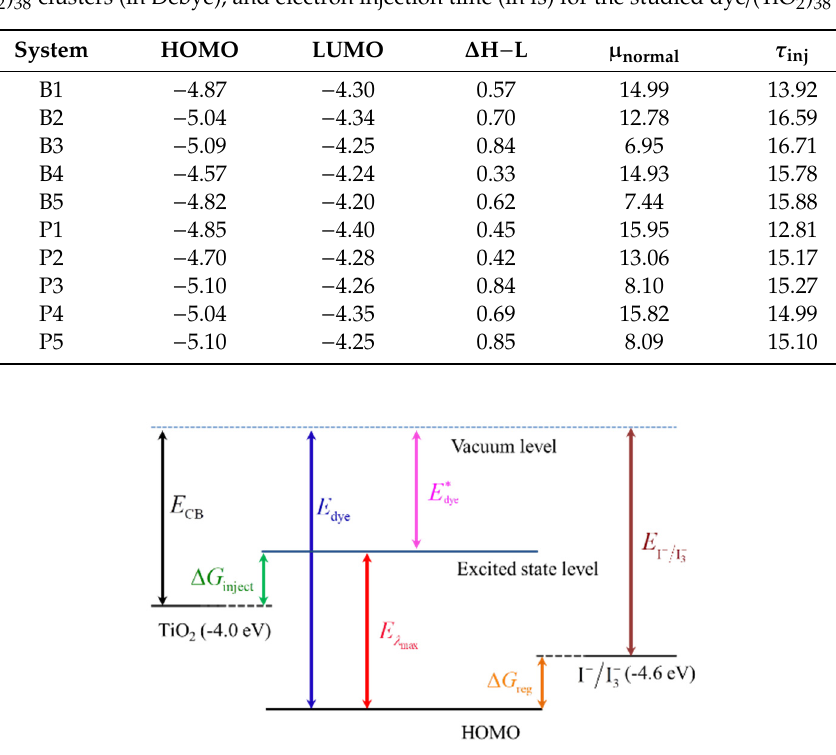
Table 4. Calculated energy level parameters (in eV), vertical dipole moment of the isolated dyes absorbed on (TiO 2 ) 38 clusters (in Debye), and electron injection time (in fs) for the studied dye/(TiO 2 ) 38 systems.